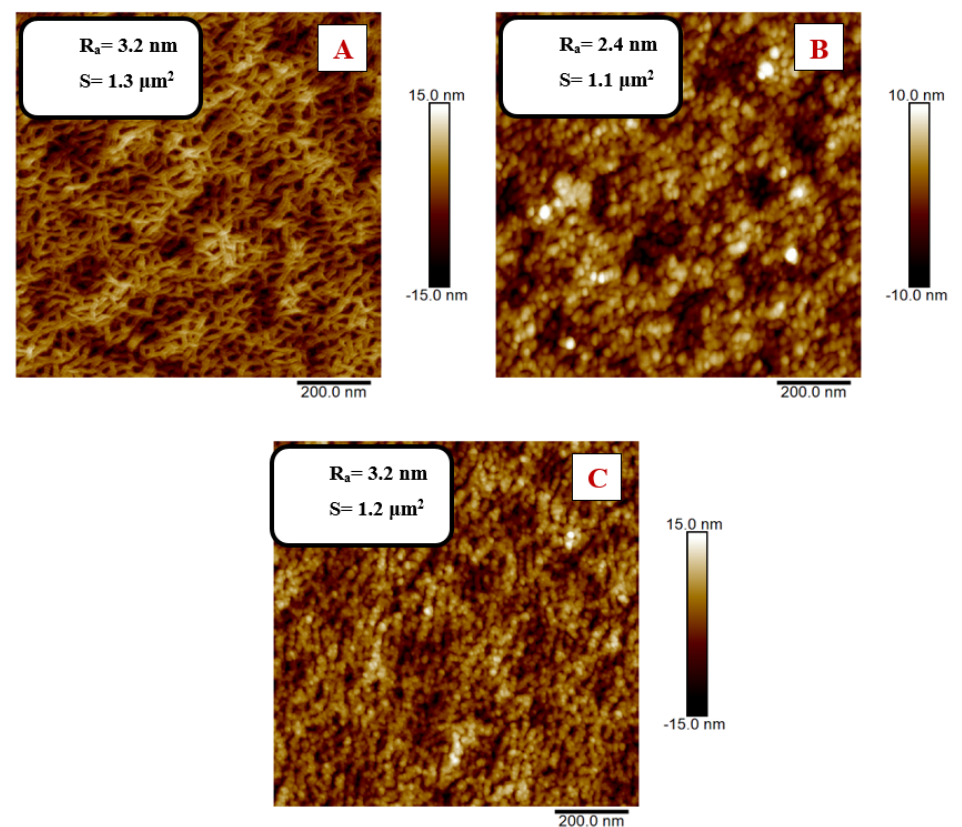
Figure 11. Two-dimensional AFM images of PEN that was modified using plasma for 200 s at 8 W power: ( A ) non-grafted sample; ( B ) grafted in AuNP/NALC (1.5 g)/H 2 O (100 mL)/PEG solution, AuNP deposition time 600 s; ( C ) grafted in AuNP/NALC (1.5 g)/H 2 O (100 mL)/PEG solution, AuNP deposition time 900